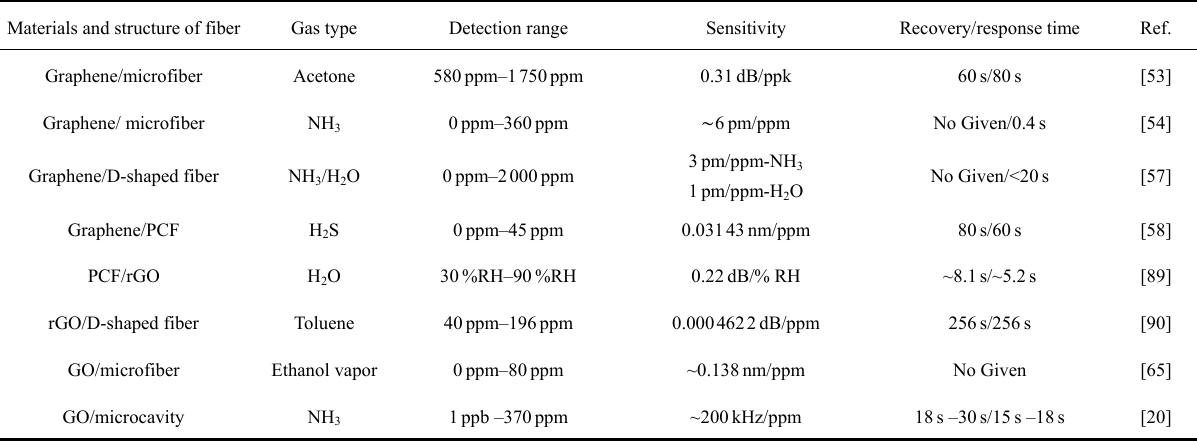
Table 1 Summary of sensing performances for gas sensors. Materials and structure of